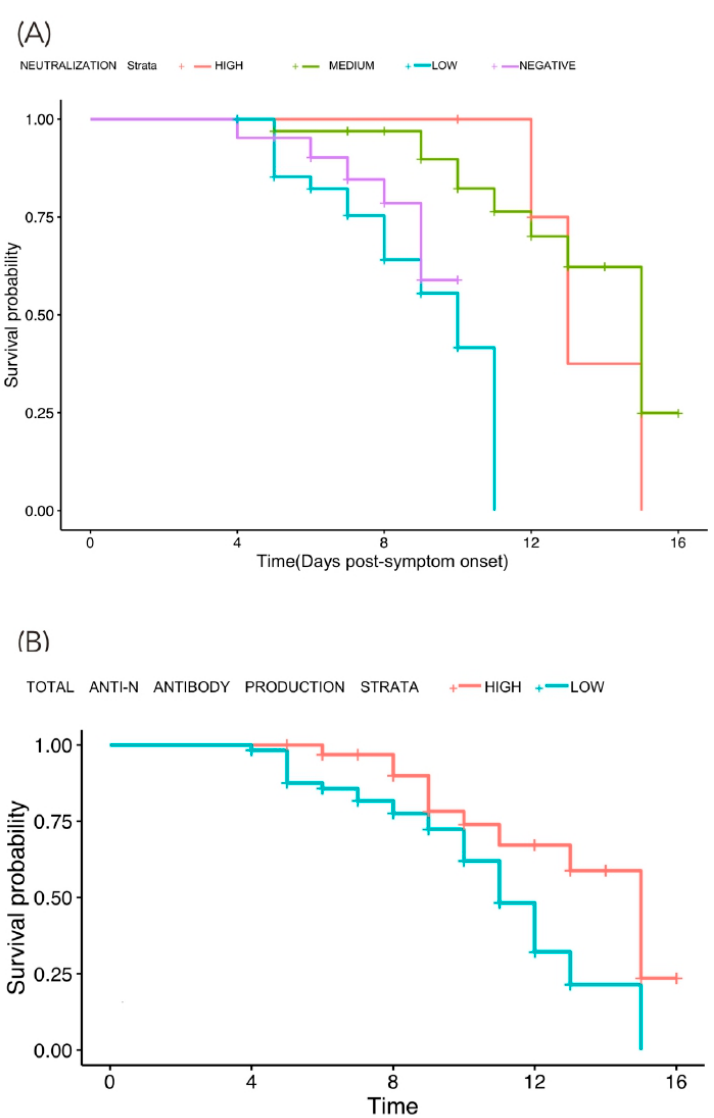
Figure 4. ( A , B ). Antibody titers and survival analysis. Kaplan–Meier Curves coupled with the Cox test was constructed to evaluate survival probability according to the neutralization categories (low, medium, and high) and the total anti-N antibody titers (low and high). ( A ): Kaplan–Meier curve showing the neutralization categories in which patients were classified in their initial measurement and the decrease in survival probability in patients with a negative or low antibody production. ( B ): Kaplan–Meier curve showing the total anti-N production classification (high and low) in which patients were classified in their initial measurement and the decrease in survival probability in patients with a low total anti-N antibody production. ( A ) p = 0.00025, ( B ) p = 0.0359.